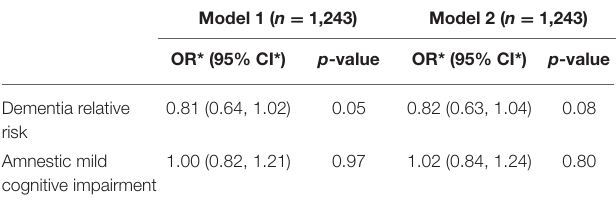
TABLE 4 | Logistic regression models of the risk of dementia and amnestic mild cognitive impairment on watching TV (hours/day), sociodemographic characteristics and functional status at baseline (model 1); and adding baseline global cognitive function for dementia relative risk and the corresponding baseline score for amnestic mild cognitive impairment (model